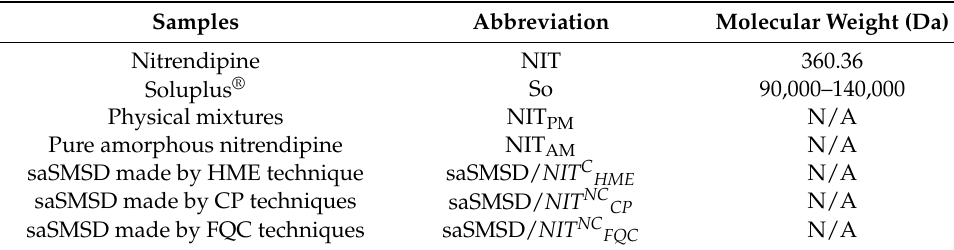
Table 1. Abbreviation of different samples in this